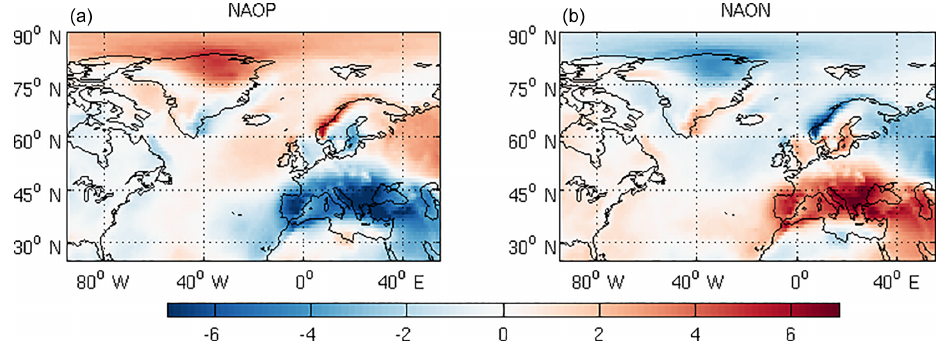
Figure 15. Ensemble mean of model-simulated total cloud fraction anomalies (%) as a response to the (a) positive phase of NAO and (b) negative phase of